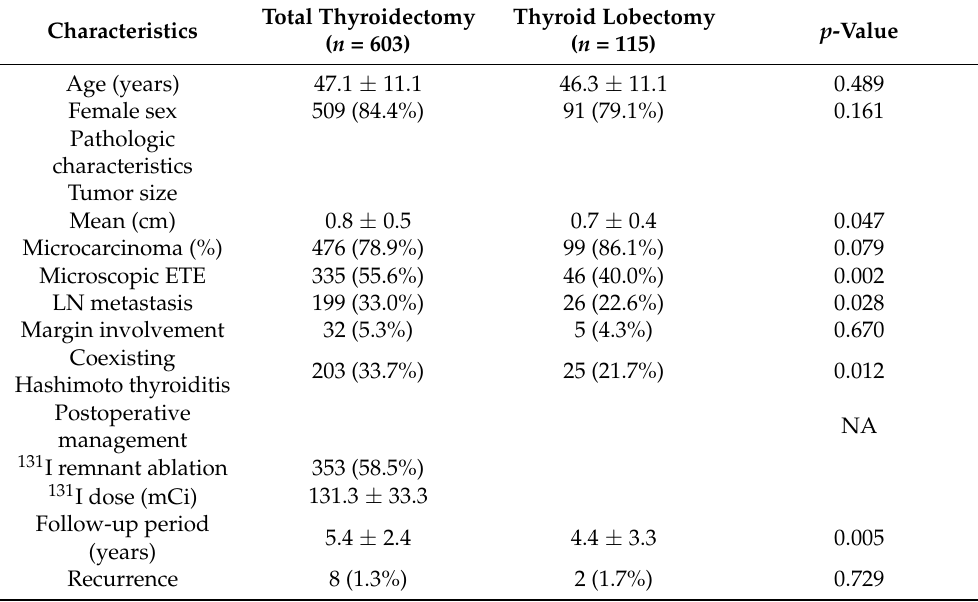
Table 1. Comparison of clinicopathological characteristics between lobectomy and total thyroidec- tomy